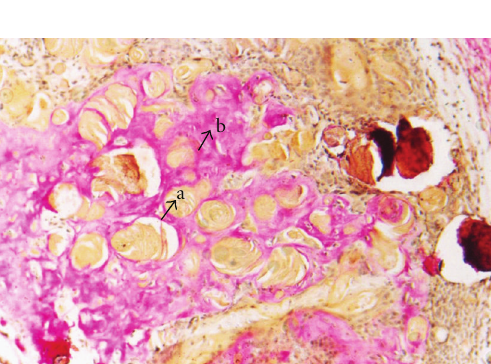
Figure 6: Van Gieson stains showing ghost cells staining yellow (a) and surrounding dentinoid-like material staining pink (b) [Van Gieson stain, ×